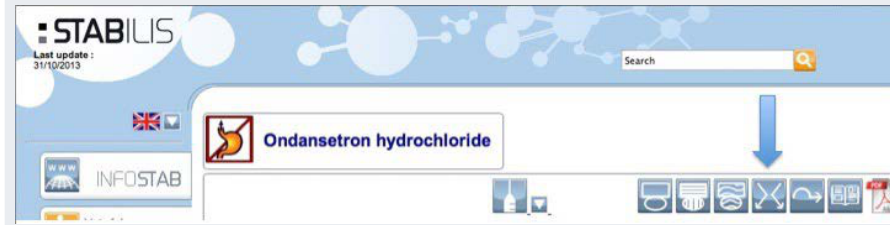
Figure 1 : The buttons of the ondansetron monograph with the button «incompatibilities»